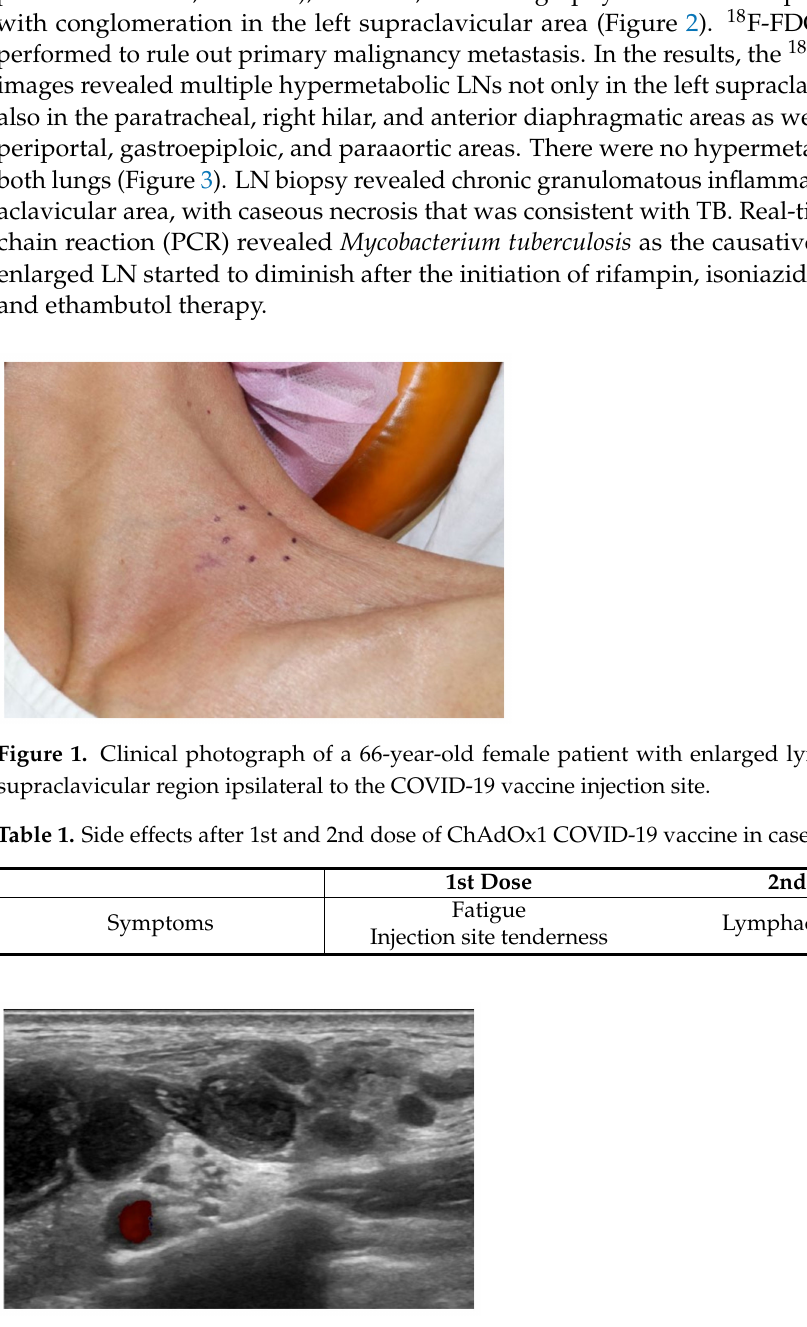
Figure 2. Ultrasonography scan of COVID-19 vaccination-induced lymphadenopathy patient re- vealed multiple enlarged LNs, with conglomeration in the left supraclavicular